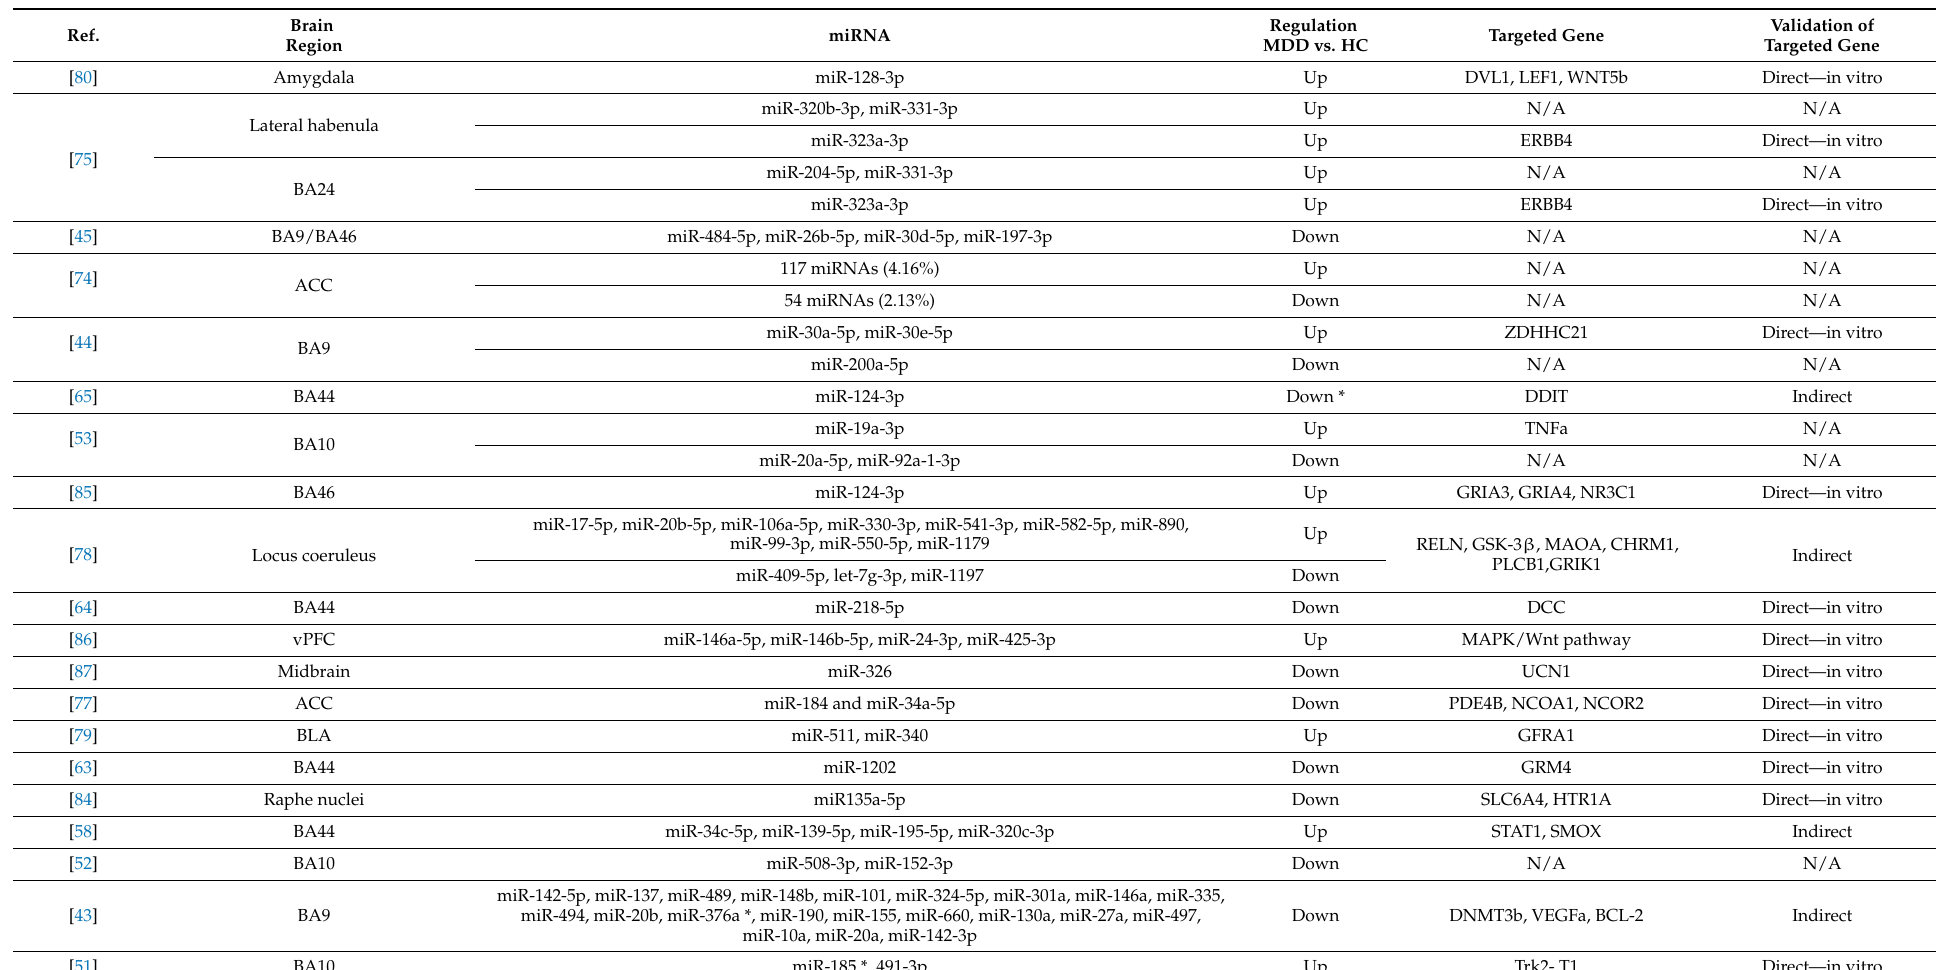
Table 1. List of post-mortem studies comparing brain miRNA expression data between depressed and psychiatrically healthy subjects.